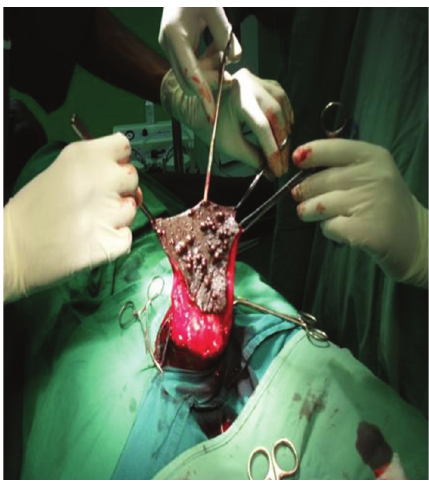
Figure 3: Excision of scrotal calcinosis.